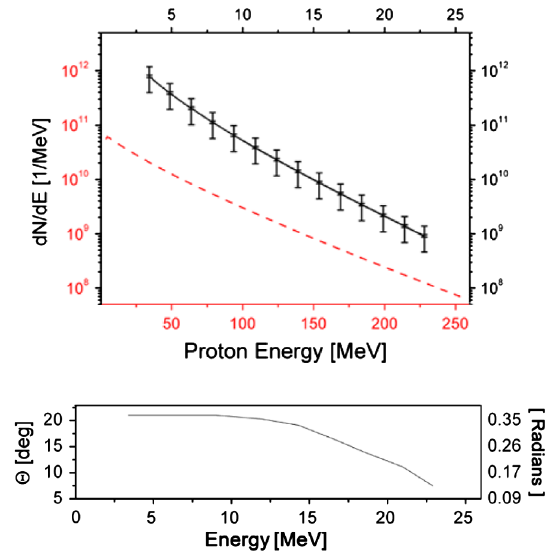
FIG. 3. Top: Processed results of the data presented in Fig. 2 (black solid curve, top and right axes, includes 5% radiochromic film imaging spectroscopy error bars and 50% shot-to-shot error bars) along with a scaled (predicted) TNSA spectrum with maximum energy of 250 MeV (red dashed curve, bottom and left axes). Bottom: Maximum beam divergence as a function of proton